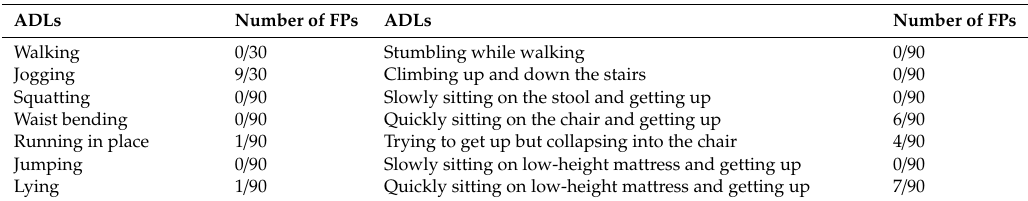
Table 2. Number of false positives that occurred during ADLs.